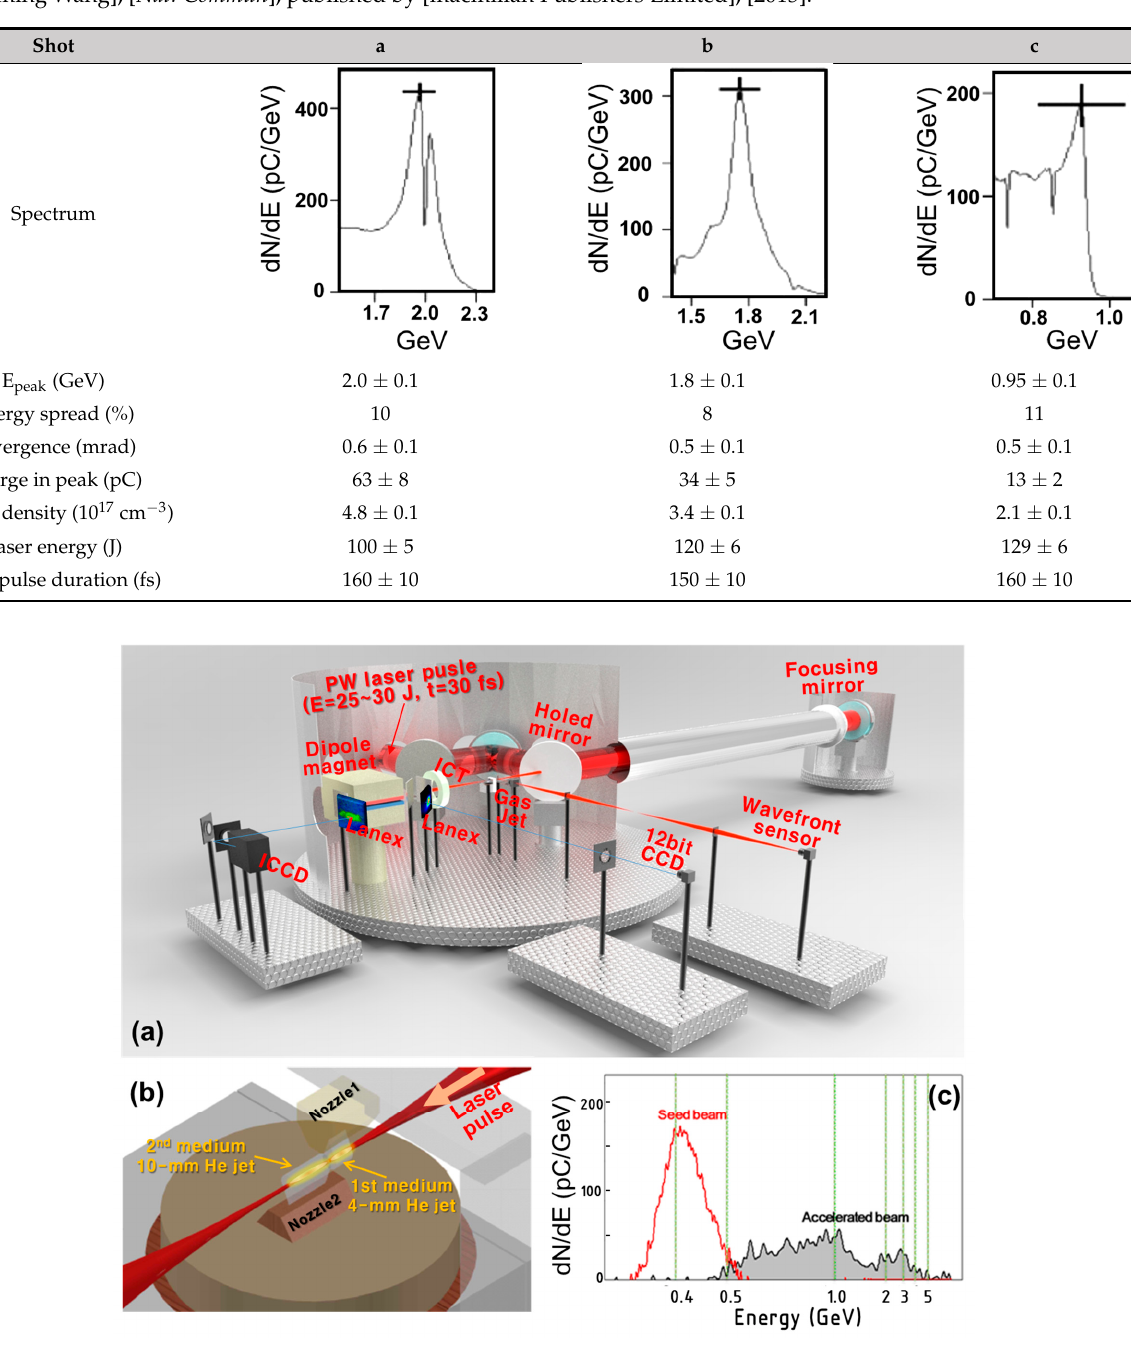
Figure 2. ( a ) Experimental layout for dual-stage LWFA with a PW laser pulse, ( b ) schematic drawing of the dual-stage target, and ( c ) the experimental result with the dual-stage target [18]. In figure ( c ), the red line shows the electron spectrum from the first target, and the black line shows the spectrum after the second target.